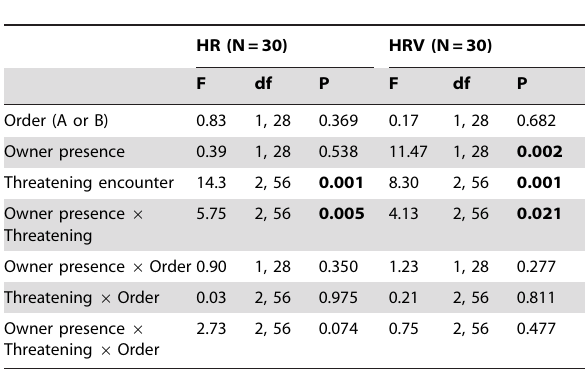
Table 1. Results of the repeated measures ANOVA regarding the change of the cardiac responses of the whole sample of